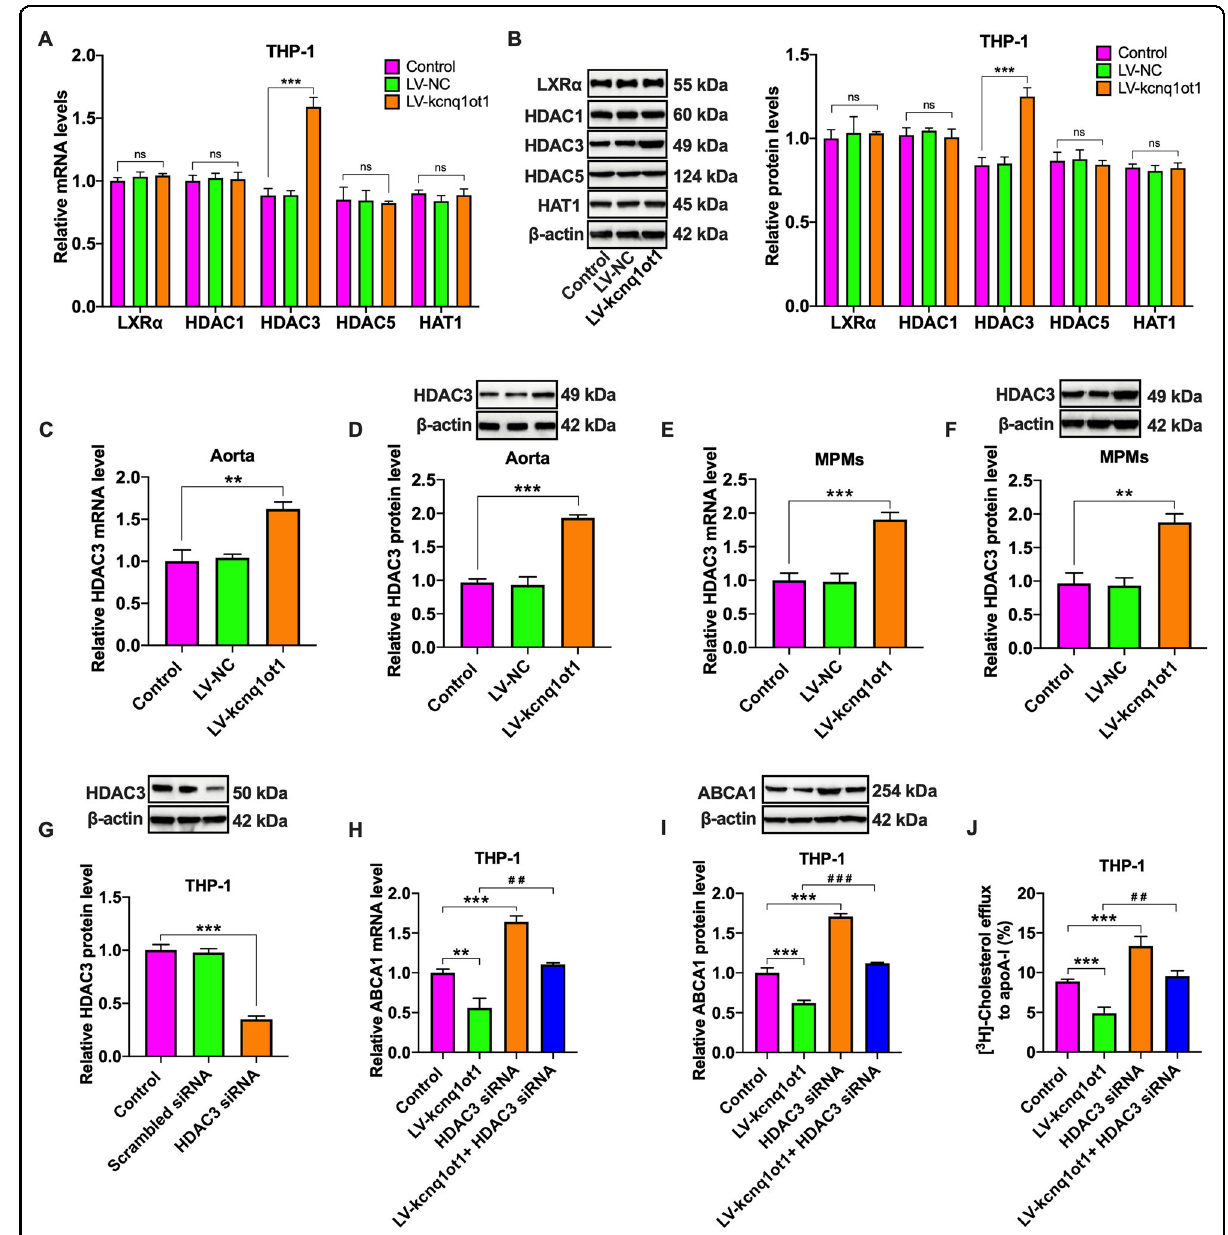
Fig. 5 Involvement of HDAC3 in kcnq1ot1-induced downregulation of ABCA1 expression. A , B THP-1 macrophages were transfected with PBS, LV-NC or LV-kcnq1ot1 for 72 h. The expressions of LXR α , HDAC1, HDAC3, HDAC5, and HAT1 were determined by qRT-PCR and western blot ( n = 3). C , D Evaluation of HDAC3 expression in the aorta from apoE − / − mice ( n = 10). E , F Detection of HDAC3 expression in MPMs from apoE − / − mice. G THP-1 macrophages were transfected with scrambled siRNA or HDAC3 siRNA for 24 h, and the cell lysates were immunoblotted with indicated antibodies ( n = 3). H – J THP-1 macrophages were transfected with HDAC3 siRNA for 24 h, followed by treatment with LV-kcnq1ot1 for another 72 h ( n = 3). H , I The mRNA and protein levels of ABCA1 were detected by qRT-PCR and western blot, respectively. J Detection of cholesterol ef fl ux to apoA-I using a liquid scintillation counter. Data are represented as mean ± SD. ** P < 0.01, *** P < 0.001 vs. control group; ## P < 0.01, ### P < 0.001 vs. LV- kcnq1ot1 group; ns not signi fi